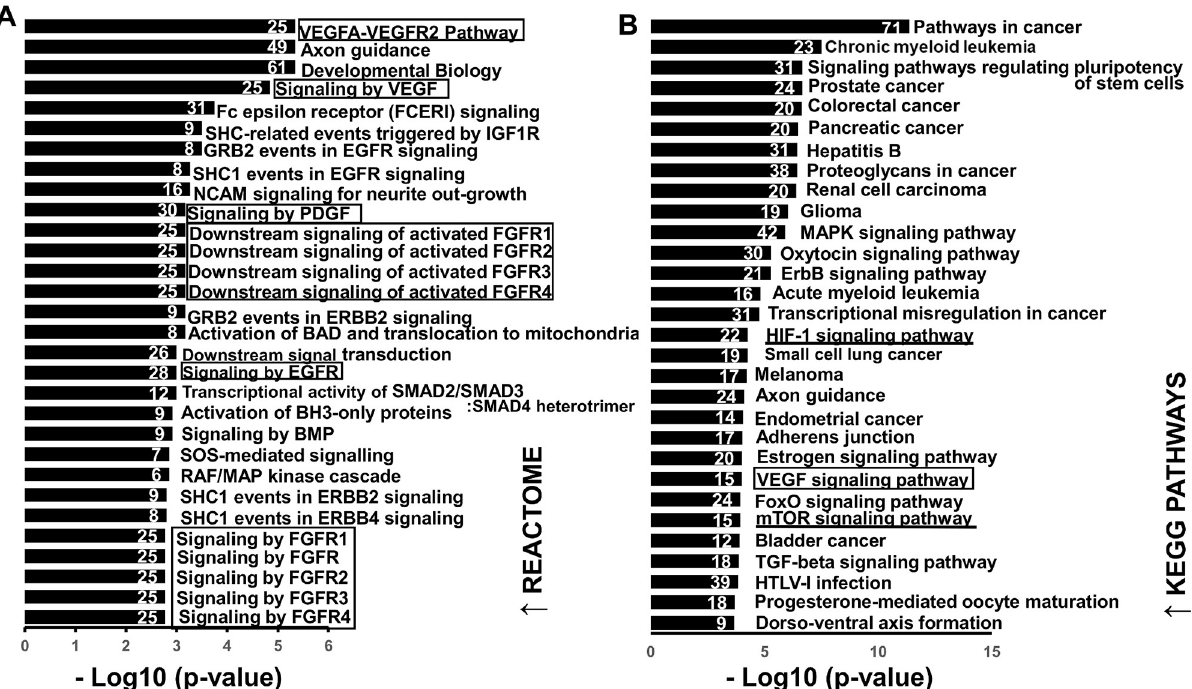
Fig 6. Functional analysis of predicted targets of down- regulated miRNAs. A and B: Top 30 overrepresented canonical pathways for up-regulated gene targets of down-regulated miRNAs according to Reactome and KEGG database, respectively. Pathways are ranked by score (-log10 ( P -value). A higher score indicates that the pathway is more significantly associated with genes of interest. Numbers inside the end of each bar indicate the number of genes involved in each pathway.